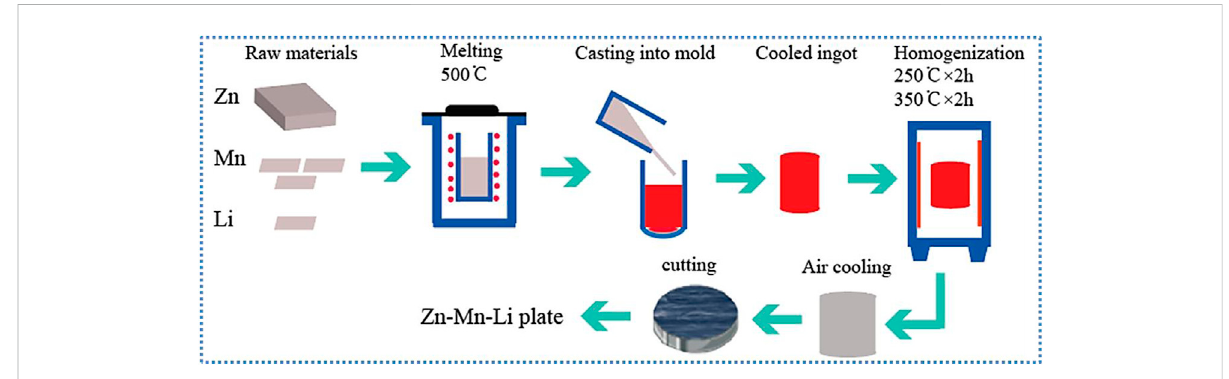
FIGURE 1 Schematic diagram of the alloys preparation route.